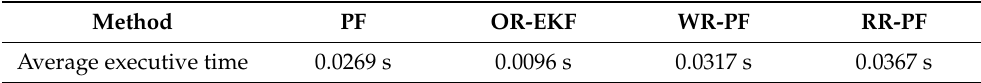
Table 1. Executive time comparisons.